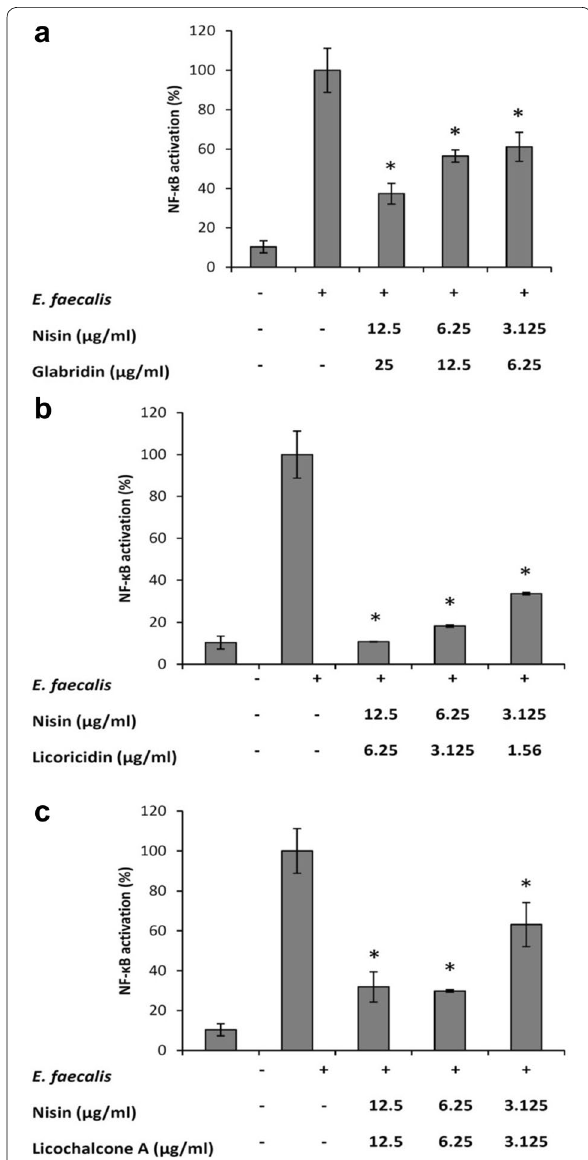
Fig. 2 Effects of nisin/glabridin, nisin/licoricidin, and nisin/ licochalcone A on E. faecalis -mediated NF-κB activation using the human monoblastic leukemia cell line U937-3xκB-LUC. *Significant reduction ( p < 0.01) compared to E. faecalis -stimulated cells (no